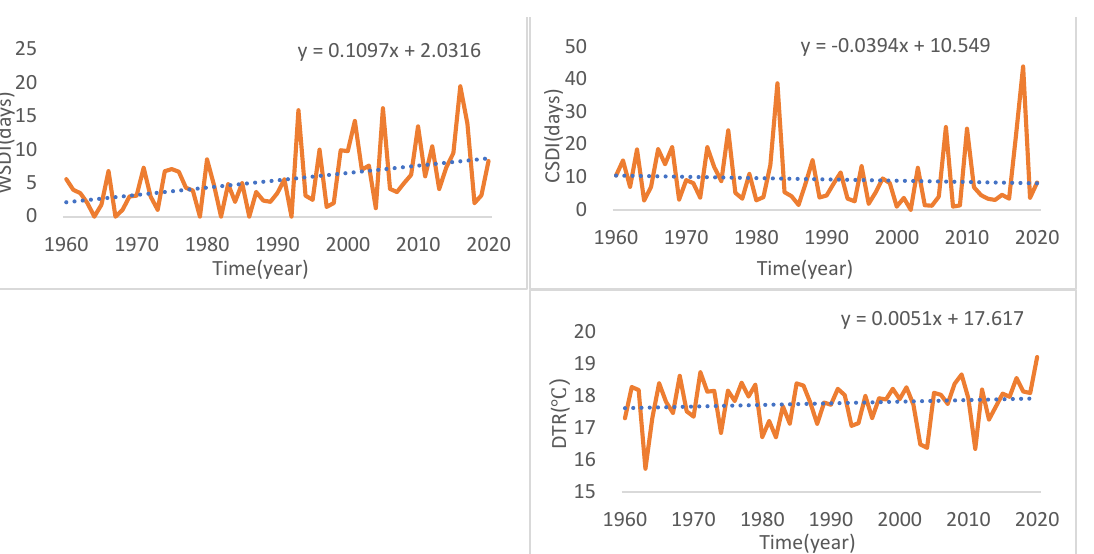
Figure 3. Interannual variation in the extreme temperature index in the Qingyi River basin from 1960 to 2020 .